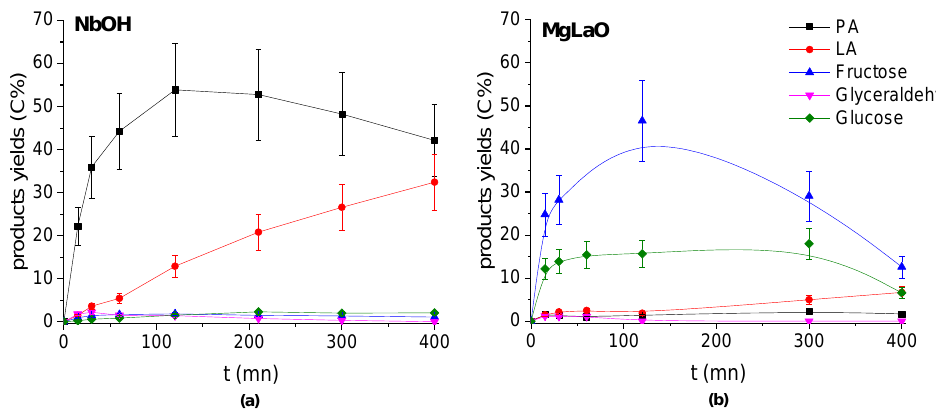
Figure 12 . Evolution of the Products’ yields with the reaction time in the presence of ( a ) NbOH and ( b ) MgLaO. Conditions : T = 90 °C, P air = 1 atm, V water = 200 mL, (DHA) = 0.1 mol.L − 1 , (catalyst) = 10 g.L − 1 .